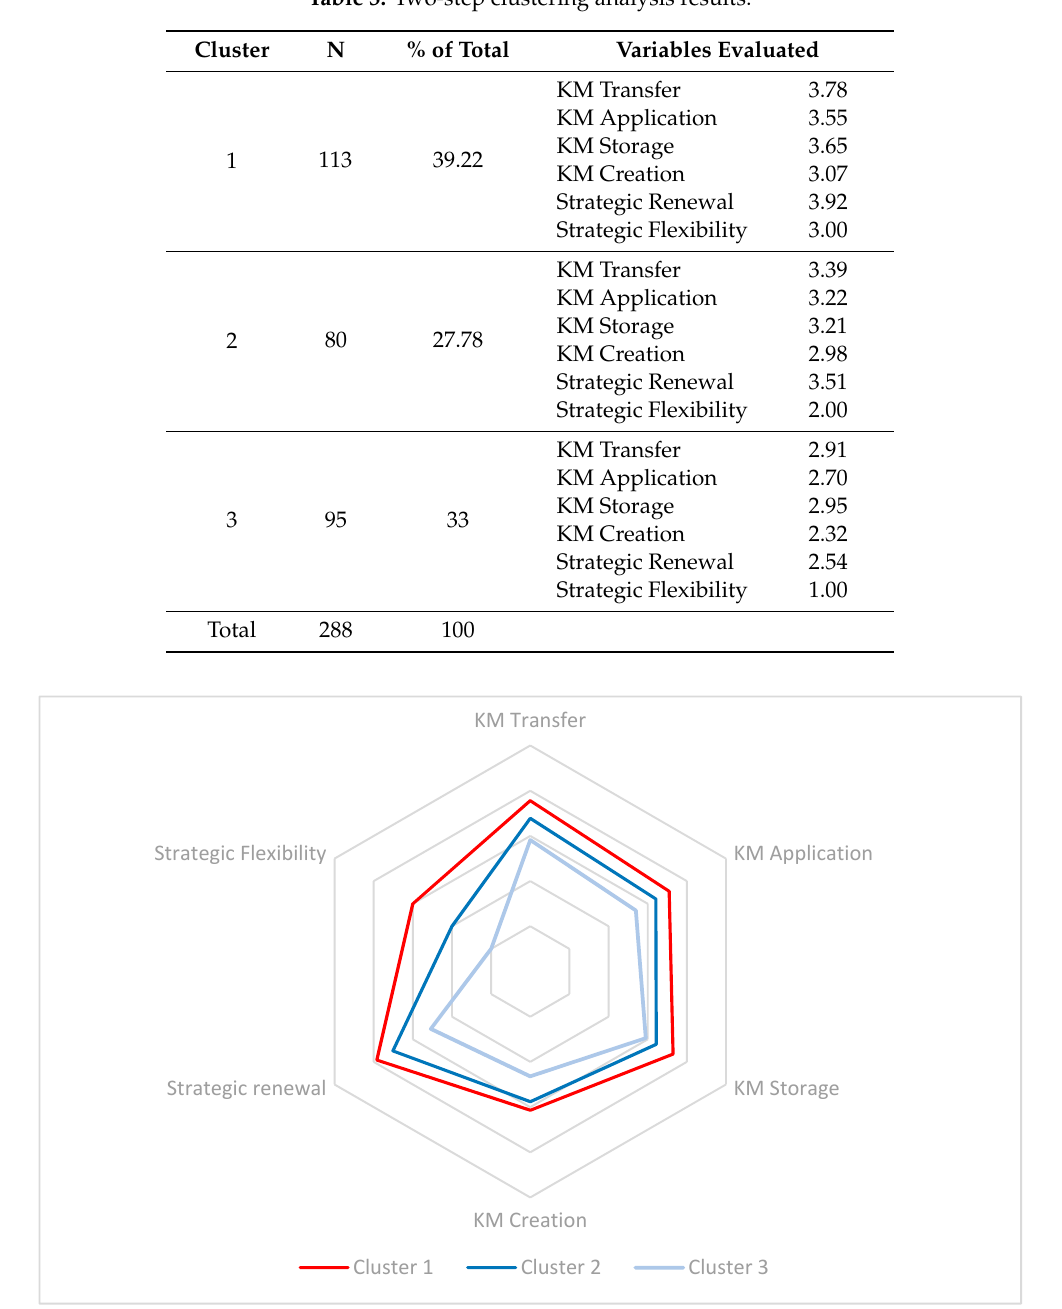
Table 3. Two-step clustering analysis results.